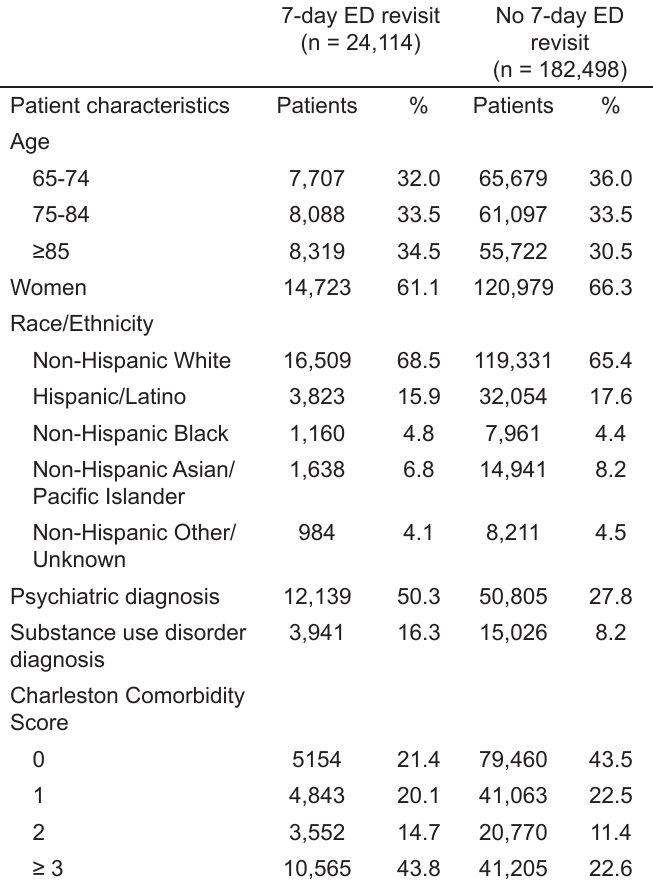
Table 1. Patient demographics of geriatric fall patients who were initially discharged with a fall-related injury and those with a seven-day emergency department (ED) revisit and without a seven-day ED revisit.